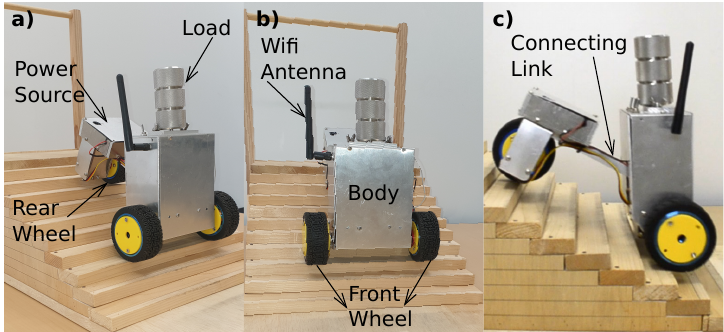
Figure 15. Model of the proposed robot; ( a ) Isometric view; ( b ) Front view; ( c ) Side view. Table 8. Parts of the robot Model. Sl. No.